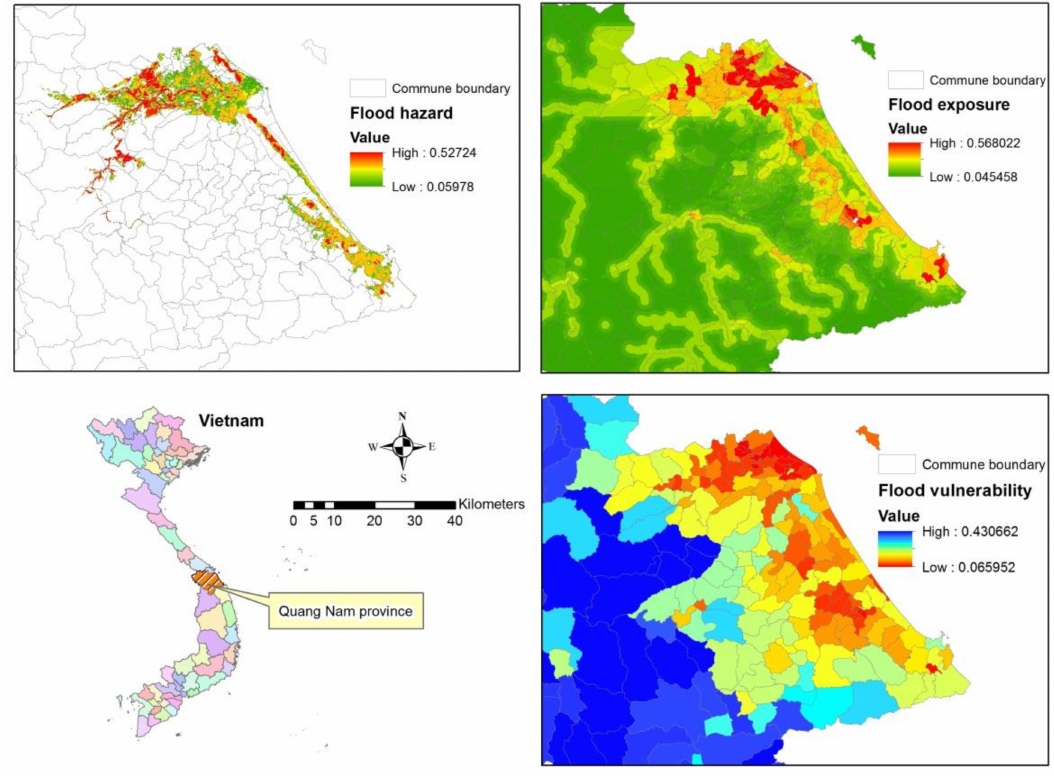
Figure 7. Spatial analysis of flood hazard, exposure and vulnerability for Quang Nam